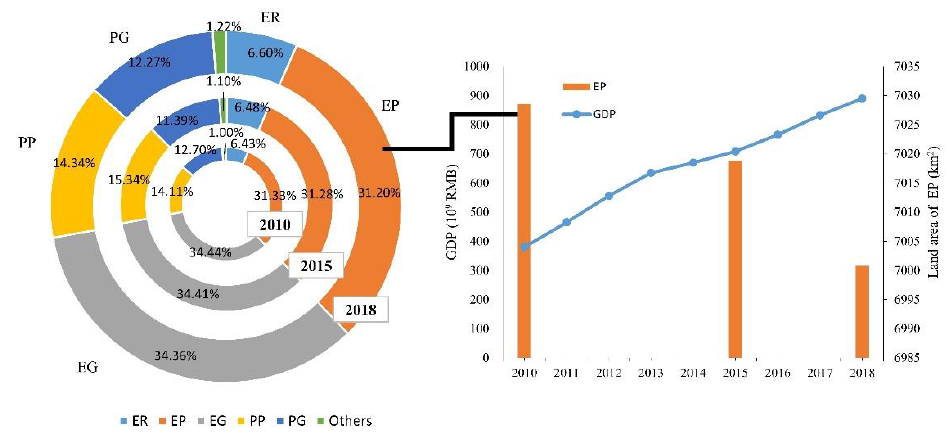
Figure 6. Changing trends of PLE space and GDP from 2010 to